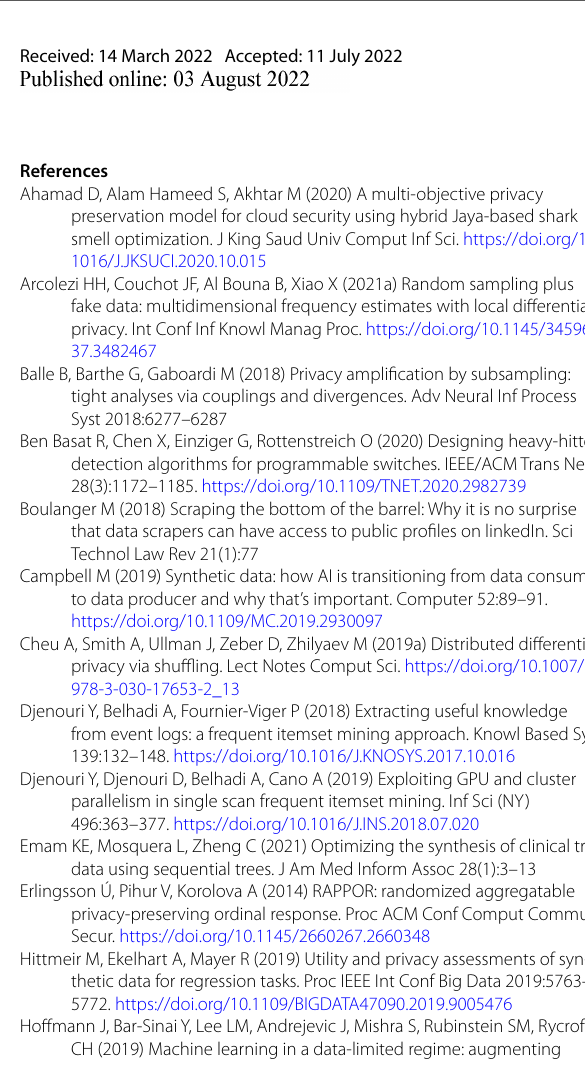
Fig. 13 The MSE averaged over 100 runs for synthetic non-uniform data with N techniques and fake data under a high privacy regime, experimental setup labeled ES_Syn_6 in Table 2; b general privacy regime, experimental setup labeled ES_Syn_12 in Table